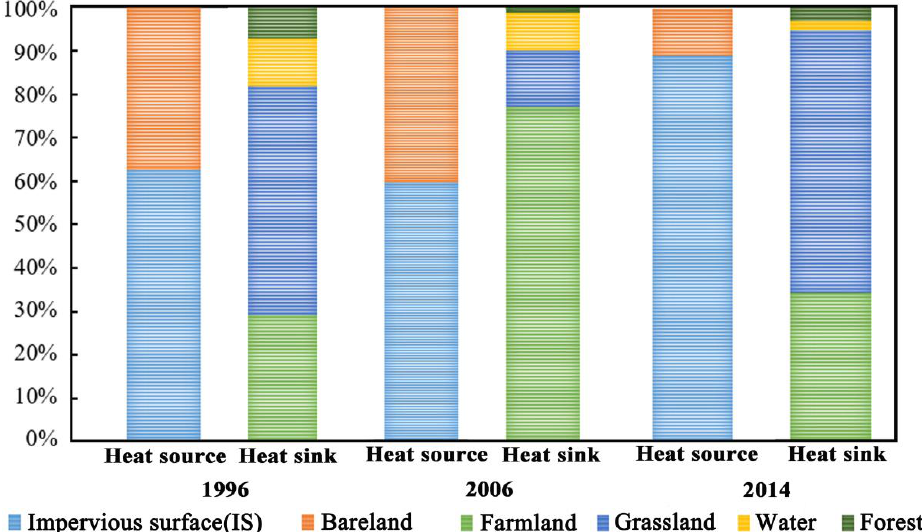
Figure 5. The composition proportion of land cover types in heat source and sink.